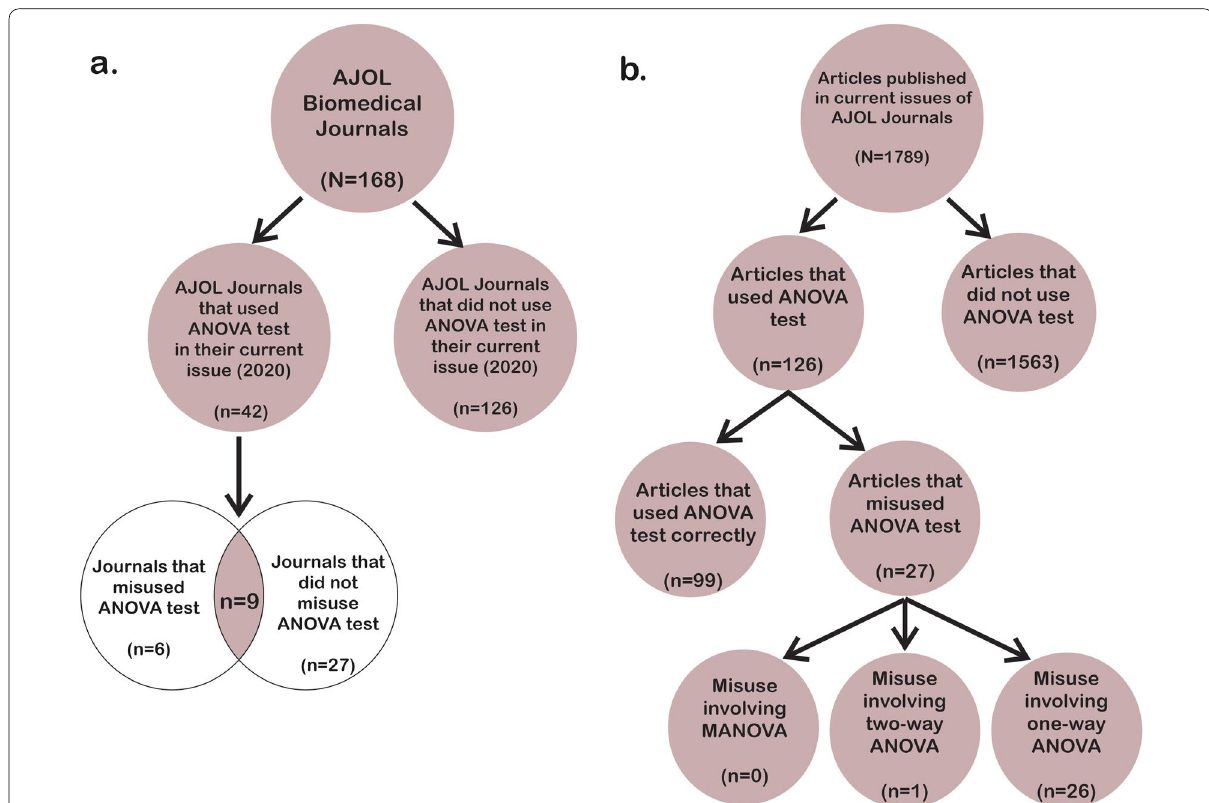
Fig. 1 Organogram of journals ( 1a ) and articles ( 1b ) that misused ANOVA tests in the current issues of journals aggregated by African Journal Online